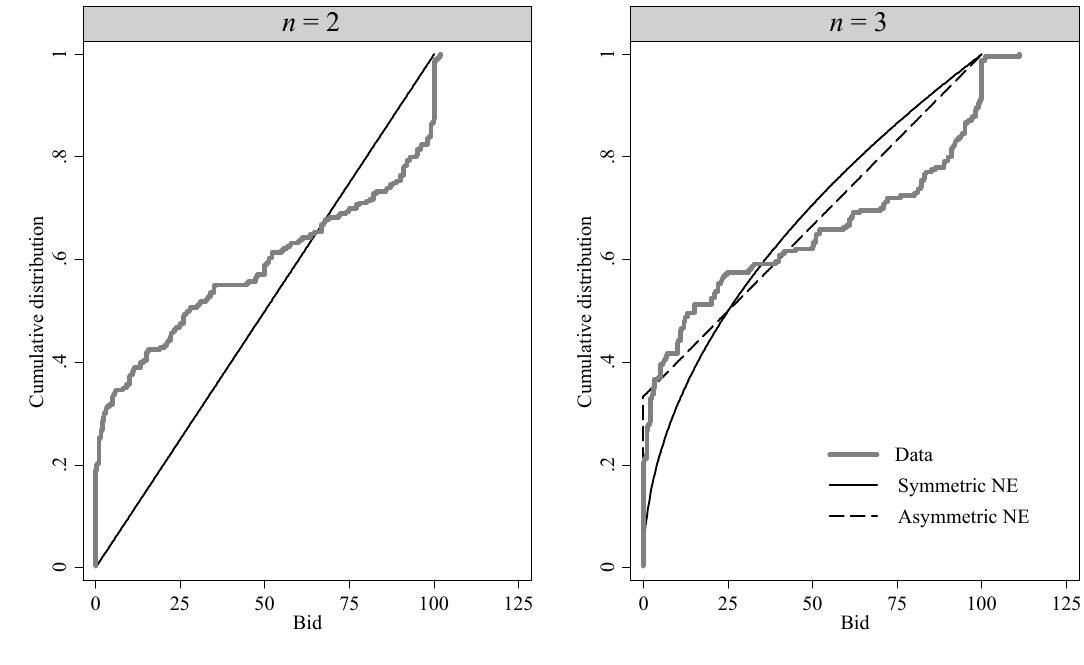
Figure 2. Nash equilibrium (thin lines) and observed cumulative distribution functions of bids by group size in the Recall treatment (bold